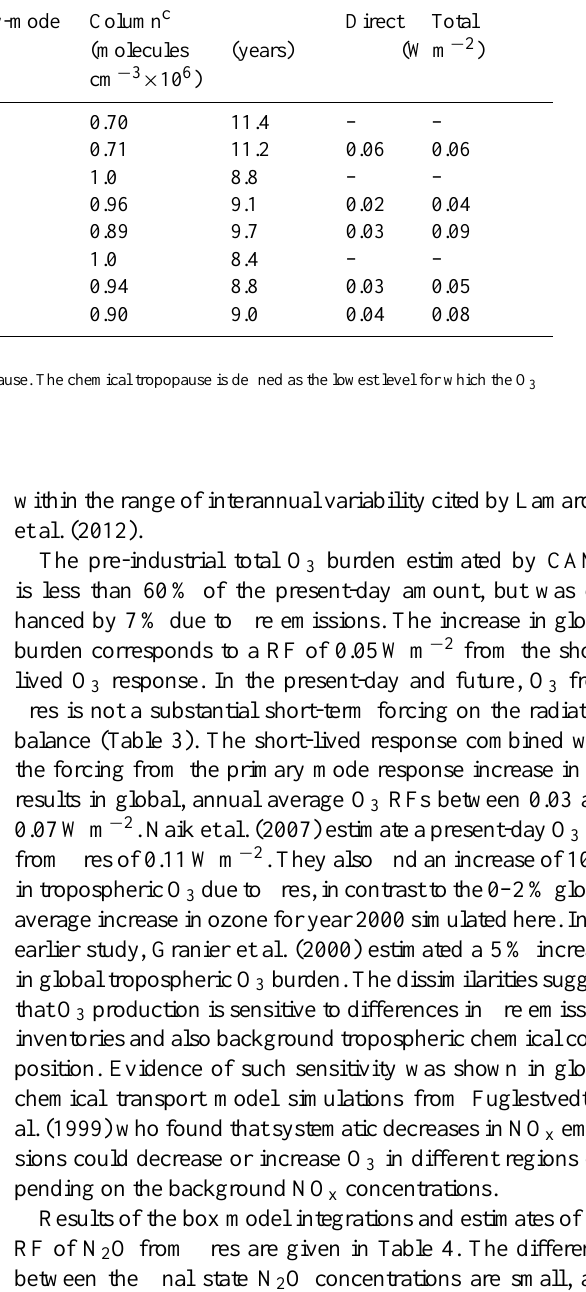
Table 3. Global annual average chemical quantities for all simulations in the CHEM group (definition of simulation names are in Table 1). [O 3 ] O 3 Radiative